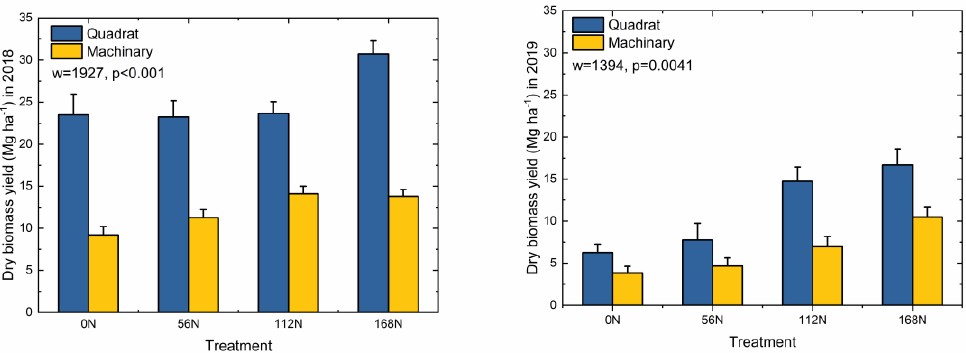
Figure 3. Dry biomass yield of Miscanthus in 2018 and 2019 growing seasons estimated from the hand-harvested 1 m × 1 m quadrats and the machine-harvested 3 m × 23 m Table 4. Average NDVI, NDRE, GNDVI, dry matter (DM) yield, and fresh matter (FM) (Mg ha −1 ) yield in response to nitrogen in 2018 and 2019 obtained from four 1 m × 1 m quadrats in Urbana, IL. Numbers in parenthesis indicate standard error of the differences in means when analyzed by sam- pling date. Different letters indicate statistical differences in means due to N at p < 0.05.